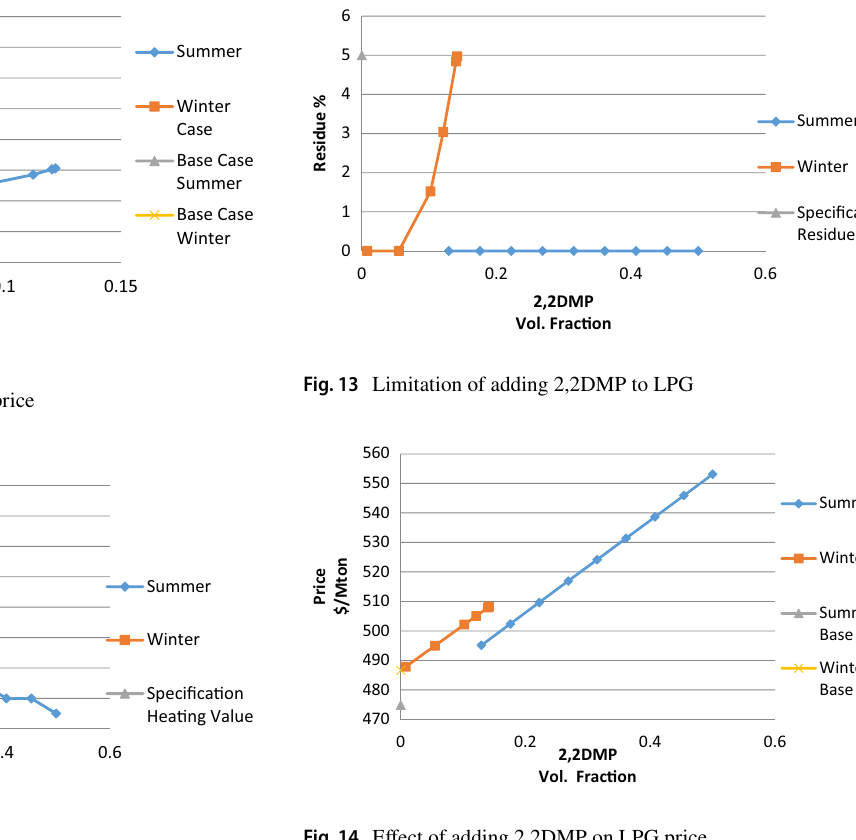
Fig. 12 Effect of adding 2,2DMP on LPG heating value